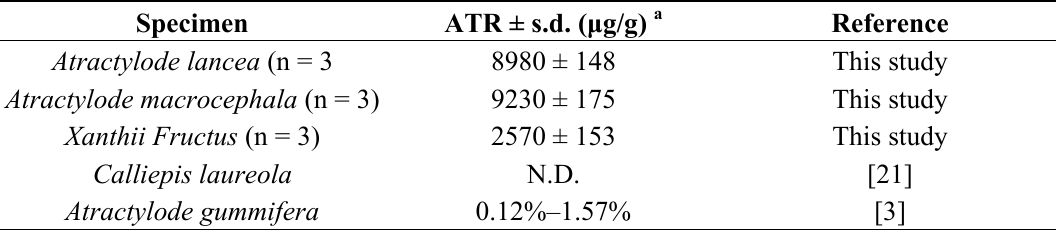
Table 1. ATR content of